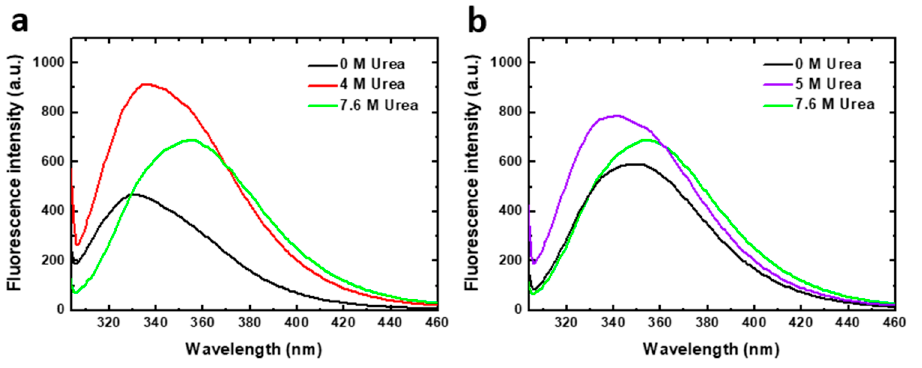
Figure 2. Tryptophan intrinsic fluorescence of human PAH in native and denaturing conditions. Emission spectra (excitation at 295 nm) of ( a ) 8 µM PAHt (full-length construction) and ( b ) 8 µM PAHd (double truncated construction) in 0, 4, 5 and 7.6 M urea.